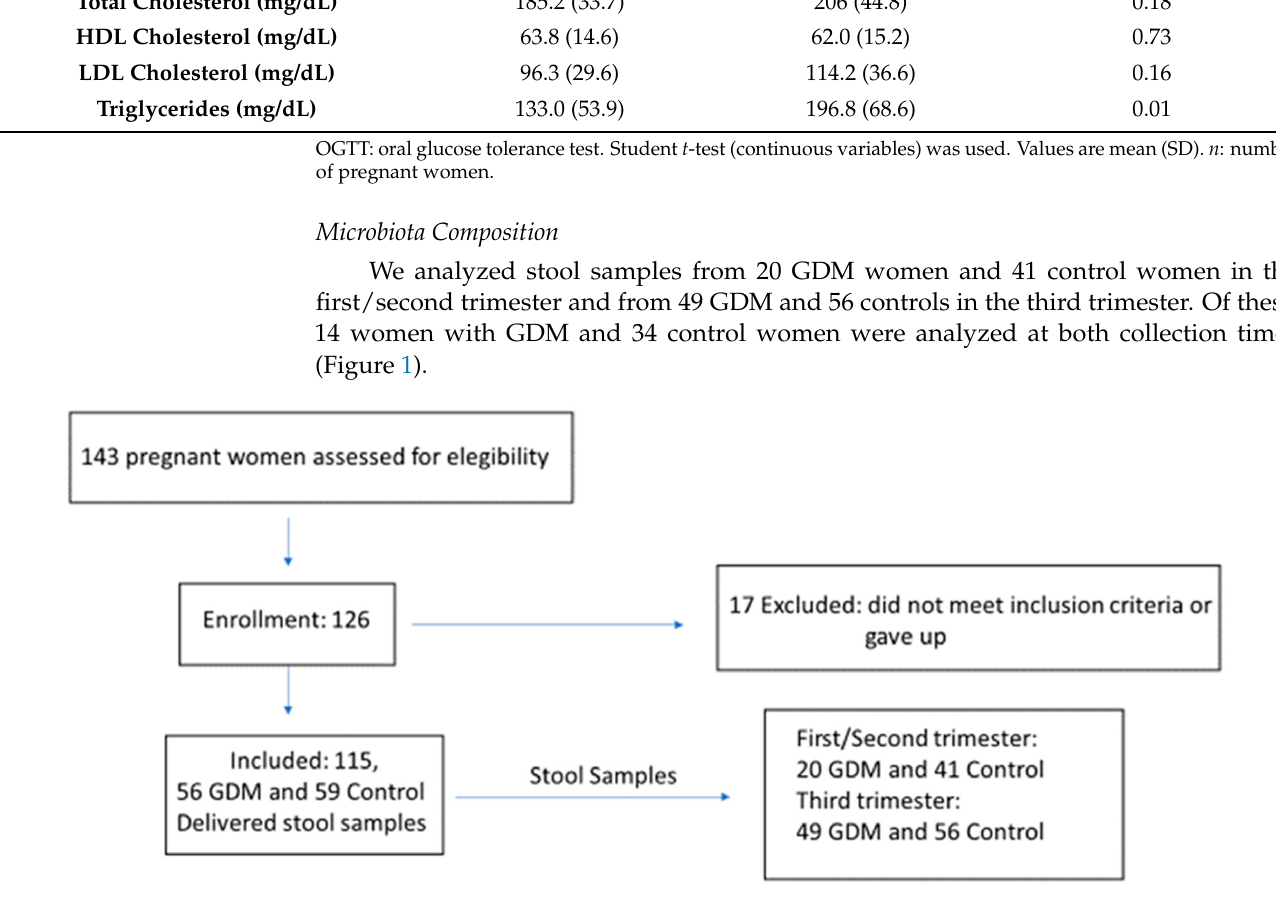
Figure 2. Microbiota structure of the total sample (panel ( A )) and groups of normal and GDM participants (panel ( B )) across gestation. Axes percentages represent the amount of variation in the data explained by the axis, calculated from the eigenvalues of PCoA (main coordinate analysis). The axes intervals represent the relative dissimilarity present between the samples. Time, trimester of pregnancy: T1/2, first or second trimesters of gestation; T3, third trimester of gestation. GDM: 0, without GDM; 1, with GDM. The comparisons of genera abundances verified a greater taxon of Bifidobacterium ( p < 0.001 and LogFoldChange: 2.42) and Peptococcus ( p < 0.001 and LogFoldChange: 2.74) in the third trimester ( Figure 3, panel A ) than in the first/second trimesters in both groups .